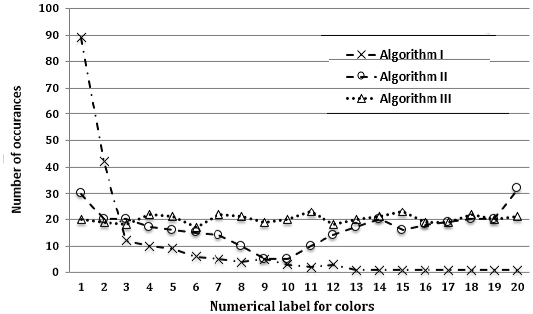
Figure 7. Unpredictability of different algorithms. Here totally 20 colors (vulnerable software) are assigned in the networked system, and the x-axis is the numerical label for each color.